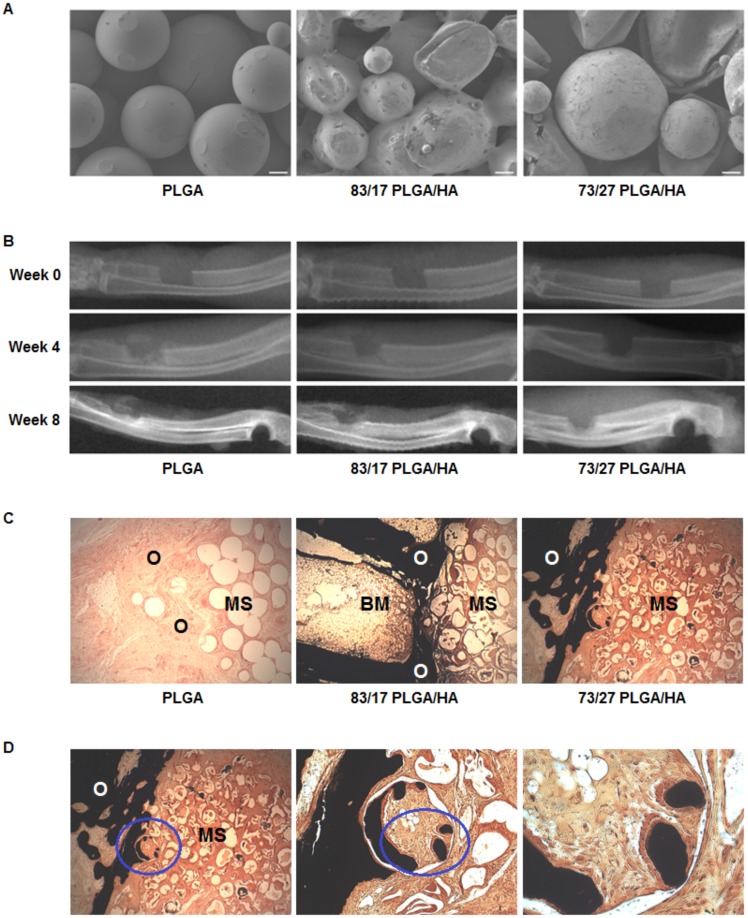

In vivo osteoinductivity of PLGA/HA composite scaffolds.(A) Representative scanning electron micrographs of sintered microsphere scaffolds (Scale Bar  = 100 µm). (B) Representative radiographs of 10 mm rabbit ulnar non-union segmental defects loaded with different scaffold compositions. (C) Optical micrographs of histological sections stained with von Kossa stain at 8 weeks (MS =  Microsphere Scaffold, O =  Osteoid, BM =  Bone Marrow; Magnification  = 40x). (D) Von Kossa staining of the histological sections for the 73/27 PLGA/HA composite scaffolds show the incorporation of microspheres into newly forming mineralized osteoid bone. The blue ellipsoid signifies the next field of view; Magnification  = 40x (left), 100x (center), and 320x (right).